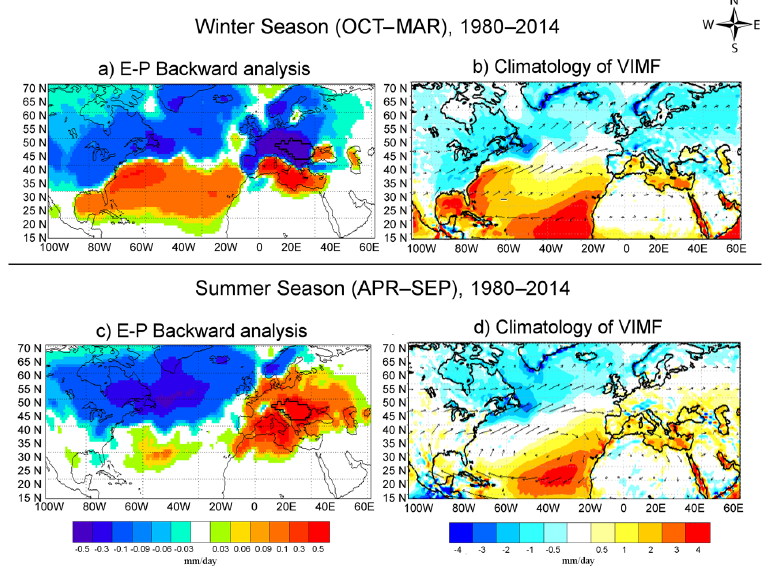
Figure 5. ( a – d ) Climatological seasonal values of 10-day integrated atmospheric moisture budget ( E-P ) obtained via backward trajectories from the DRB for ( a ) winter and ( c ) summer, and climatological seasonal vertically integrated moisture flux (vectors; in kg·m − 1 ·s − 1 ) and its divergence (shaded; in mm/day) for ( b ) winter and ( d ) summer seasons. Data obtained from ERA-Interim. Thick black contour in ( a ) and ( c ) indicates the DRB.